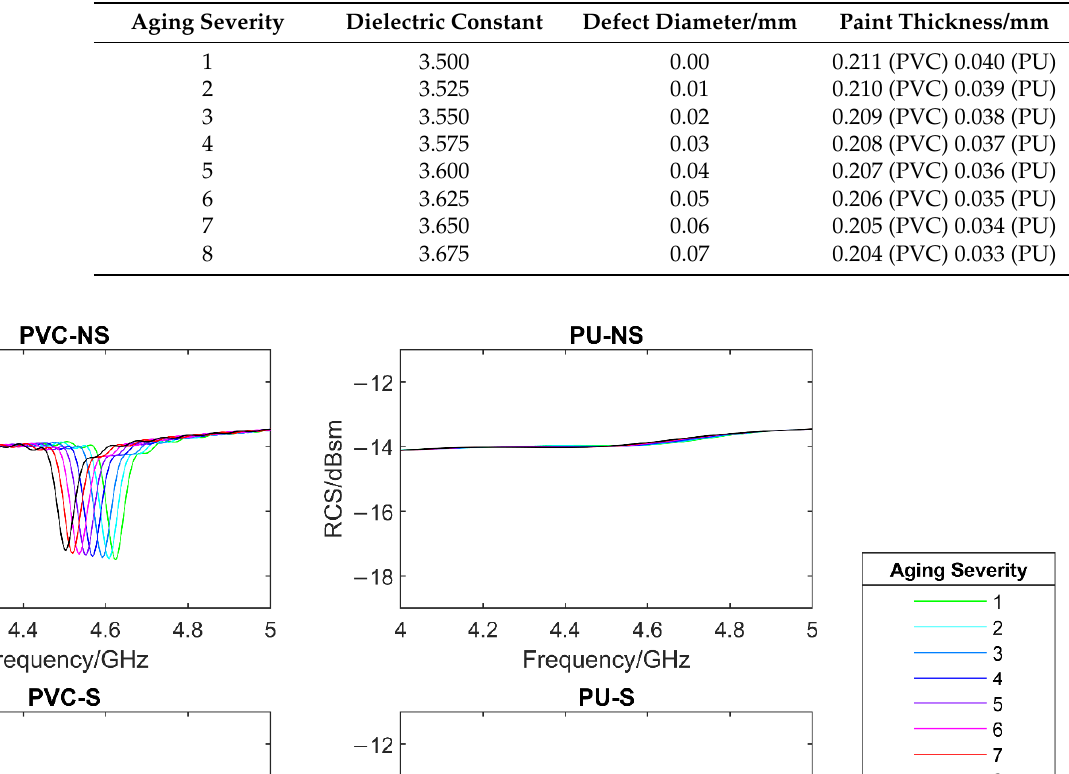
Table 5. Parameters used for each aging severity level.